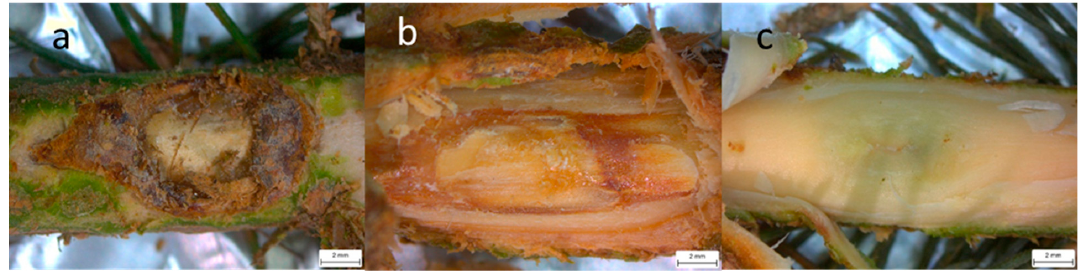
Figure 3. Measuring the necrosis in phloem and sapwood of Norway spruce saplings. ( a ) Necrosis in phloem after inoculation with H. parviporum ; ( b ) necrosis in sapwood after inoculation with H. parviporum ; ( c ) no sign of necrosis in the sapwood of mock-inoculated control.